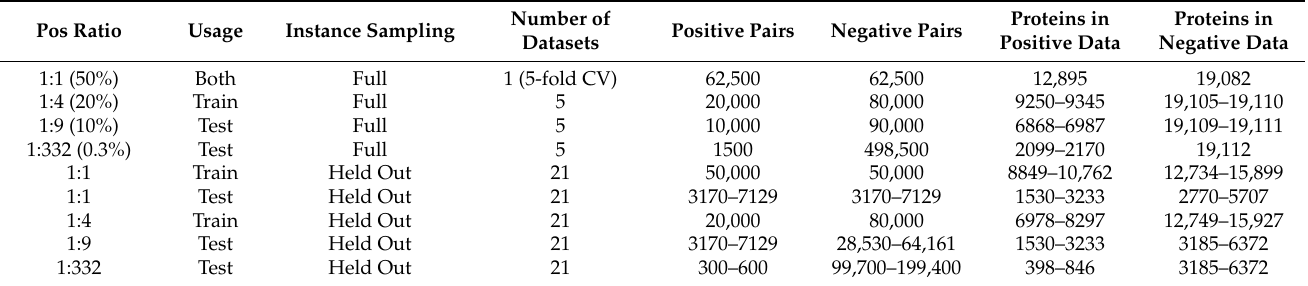
Table 1. Sizes of different datasets created for testing. Pair sizes vary for the held-out data due to the number of pairs drawn from a single bin (such as 4, 4) being half the size of drawing pairs from 2 bins (such as 3, 4). Held out test sets for